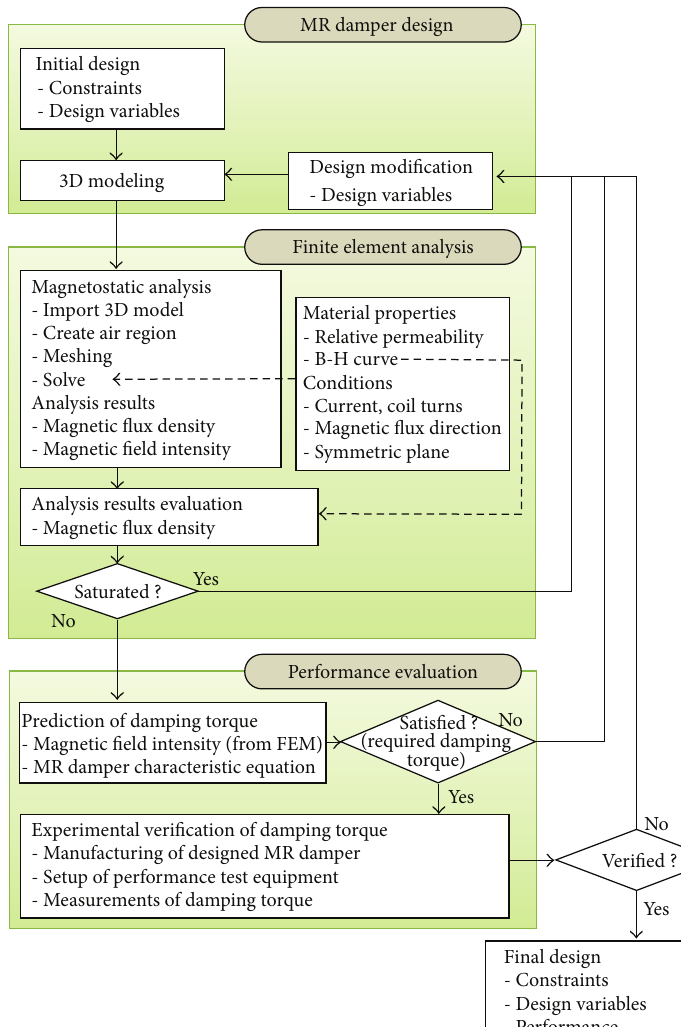
Figure 1: Design procedure of the rotary MR damper.